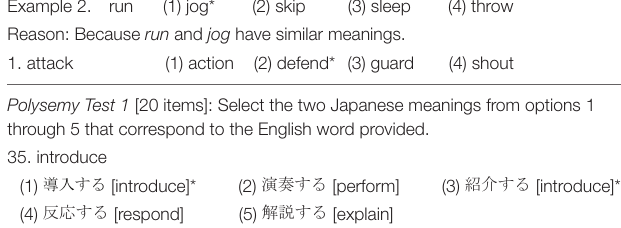
TABLE 1 | Examples of the five vocabulary tests in order of administration. Word Association Test [30 items]: Select the English word from options 1 through 4 that is most strongly associated with the given word. Example 1.